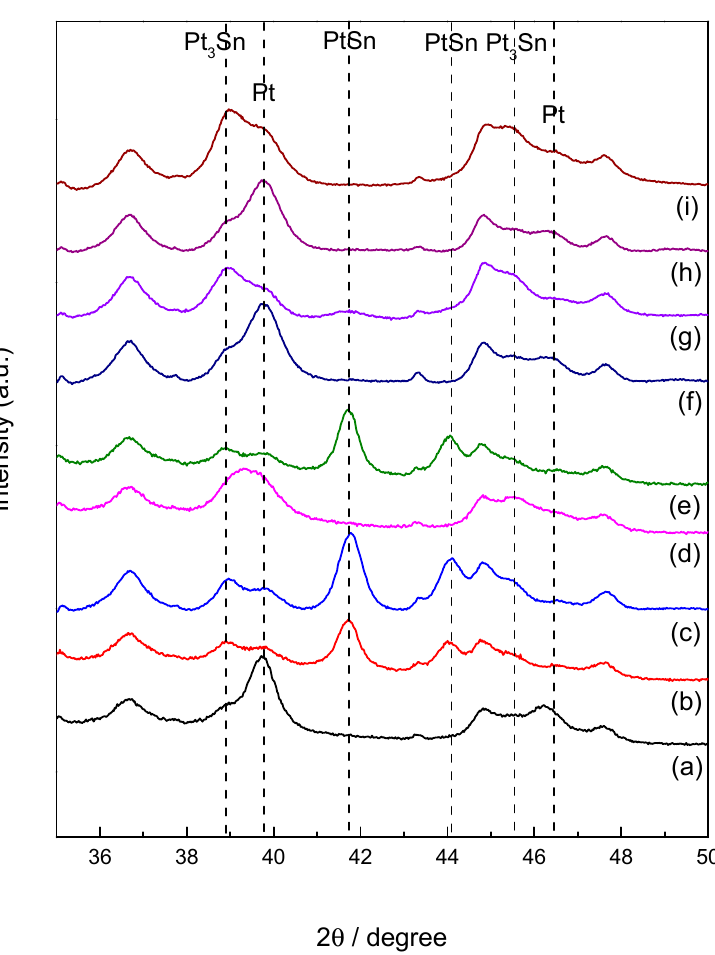
Figure 3. X-ray di ff raction (XRD) patterns of Pt-Sn / Al 2 O 3 catalysts after catalyst preparation: ( a ) PtSn-C, ( b ) reduced PtSn-C, ( c ) PtSn-U, ( d ) PtSn-B, ( e ) reduced PtSn-B, ( f ) PtSn-B-HCl5, ( g ) reduced PtSn-B-HCl5, ( h ) PtSn-HCl35, and ( i ) reduced PtSn-B-HCl35.